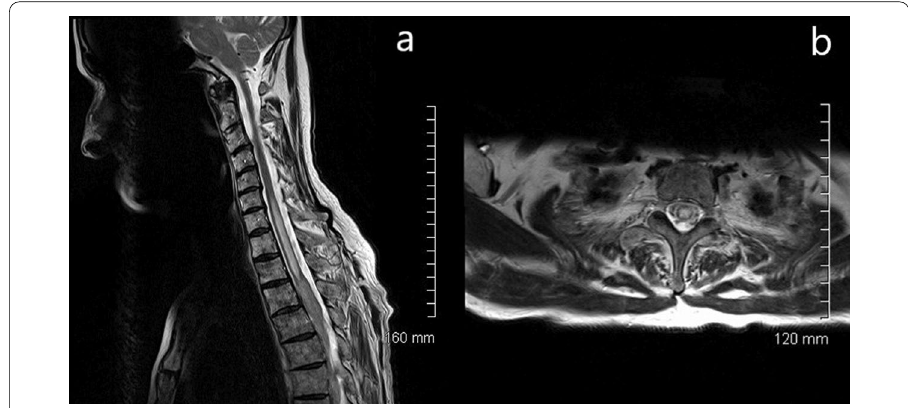
Fig. 2 Sagittal T2-weighted MR image ( a ) demonstrates a hyperintense cord lesion extending from C6 to T2/ T3. Axial image ( b ) confirms a central location within the